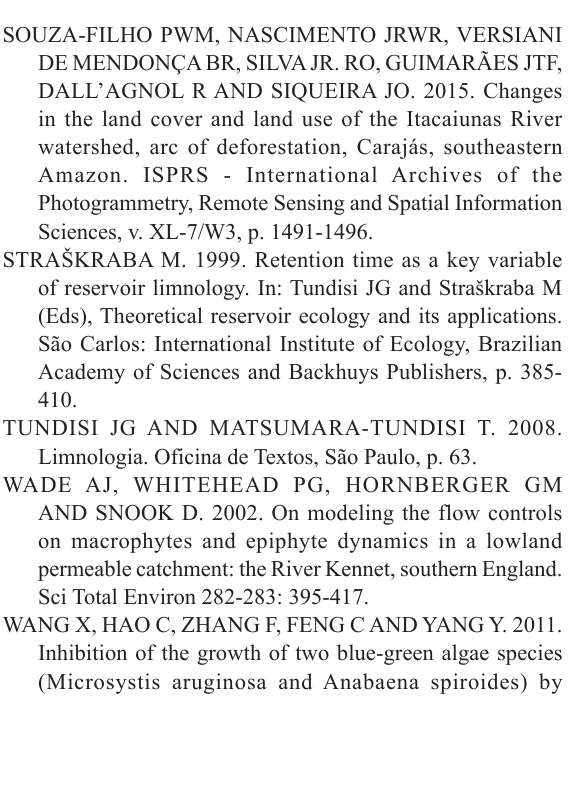
TABLE SI - The physicochemical and biological parameters of Violão and Amendoim lake. TP: total phosphorous; Ecoli: Escherichia coli ; Chl- a : Chlorophyll- a ; BDL: below detection